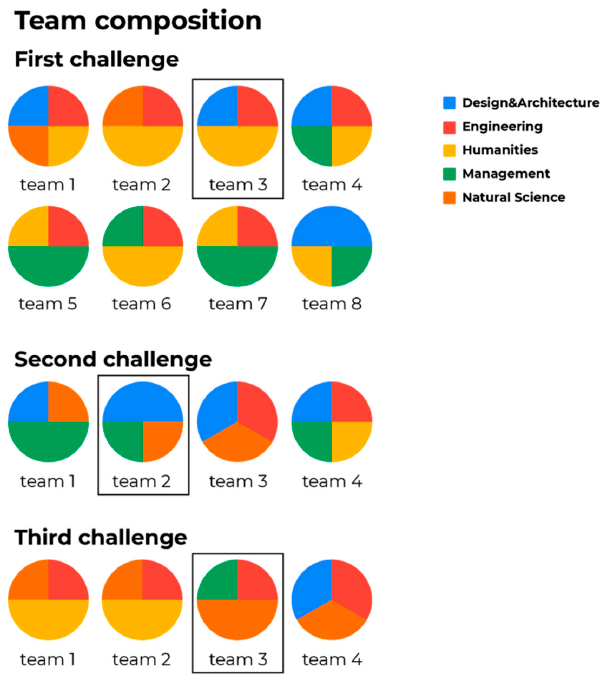
Figure 2. Team composition and winning teams.